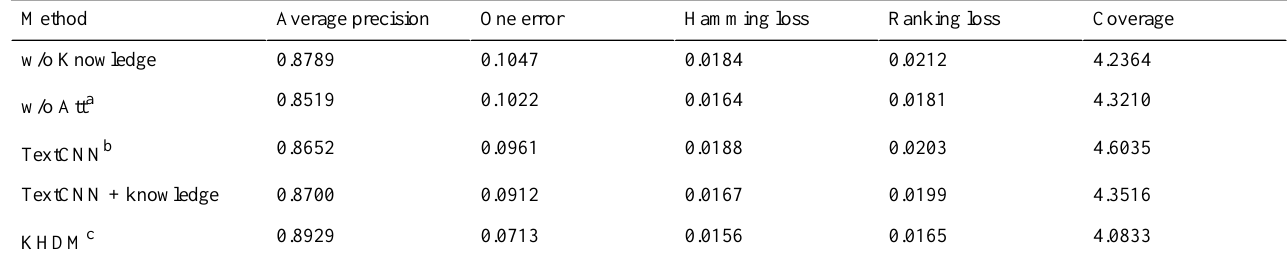
Table 5. Results of the ablation test.